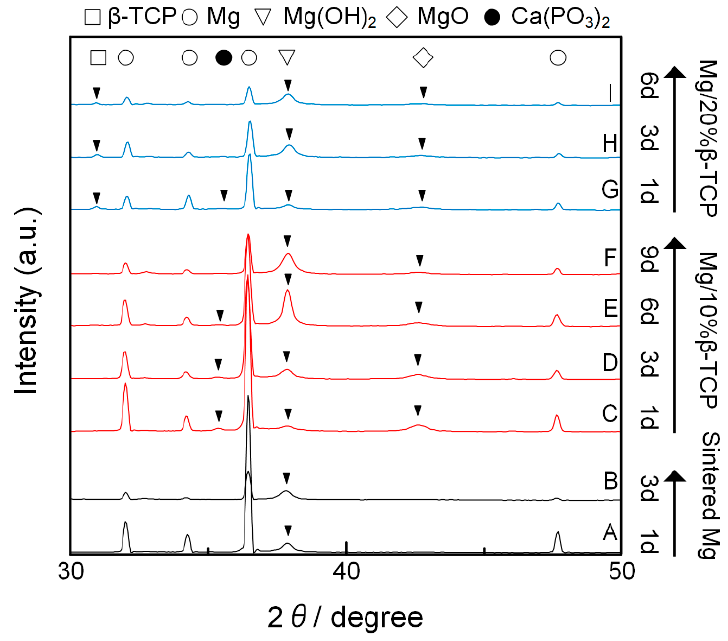
Figure 6. XRD patterns of samples of the ( A ) sintered Mg after immersion for 1 day and ( B ) 3 days; ( C ) Mg/10% β -TCP after immersion for 1 day, ( D ) 3 days, ( E ) 6 days, and ( F ) 9 days; ( G ) Mg/20% β -TCP after immersion for 1 day, ( H ) 3 days, and ( I ) 6 days. Peaks on each pattern were labeled by solid triangles except for Mg, which is seen in all patterns.